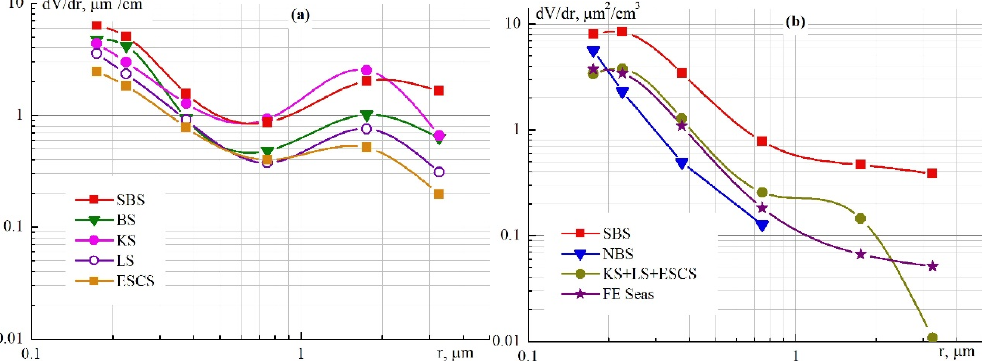
Figure 3. Average volume particle distribution functions ( dV/dr ): ( a ) multiyear (2007–2018) data; ( b ) in expedition “TransArctic–2019”.